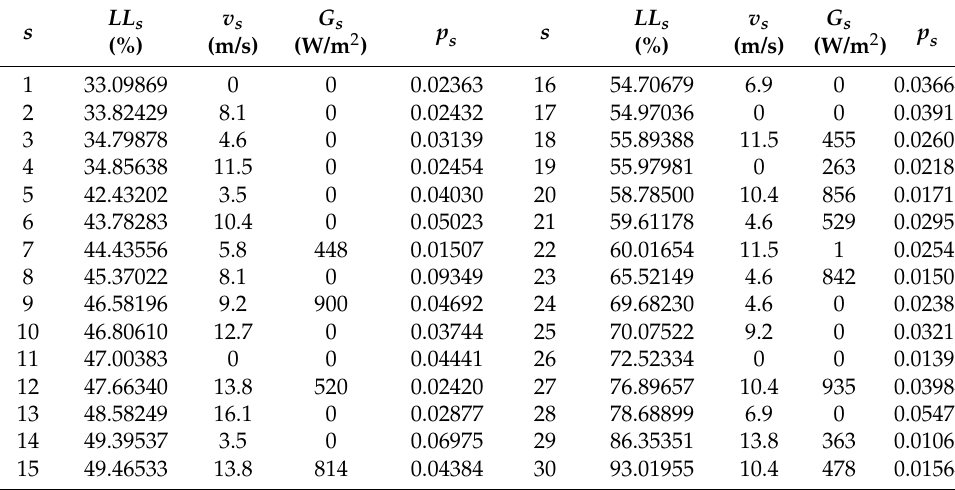
Table 1. Wind speed, solar irradiance, and load